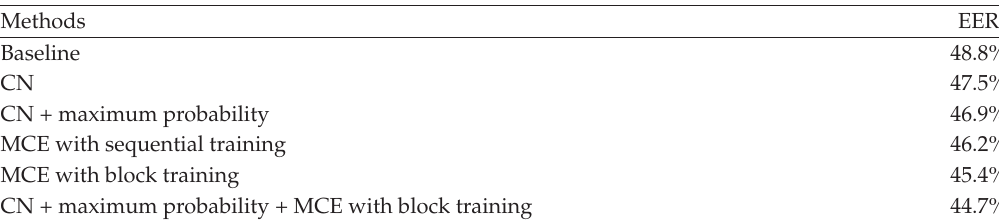
Table 3: EER of di ff erent